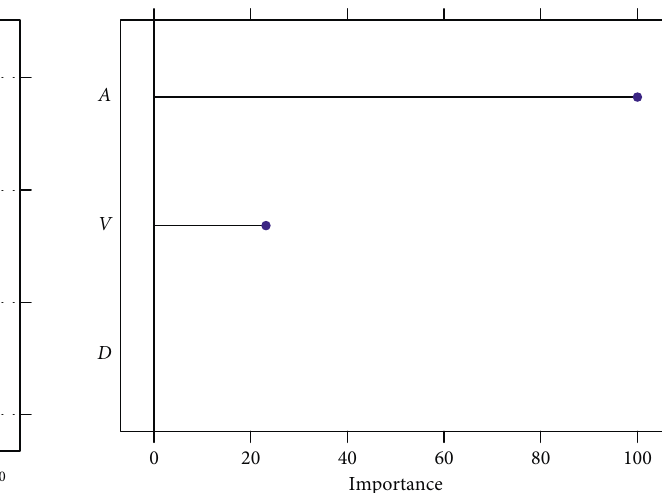
Figure 14: Variable importance scores for three predictors used in the random forest models for EDZ